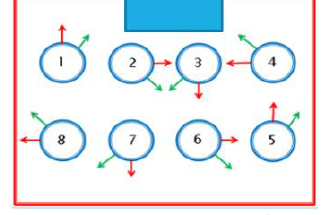
Figure 2. Data acquisition illustration for multi-camera